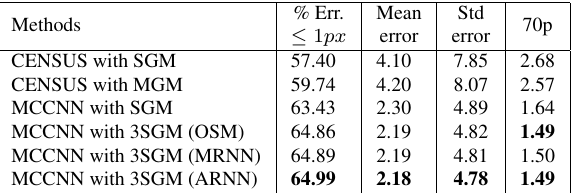
Table 4. Disparity errors (in pixels) on London (UK). All pixels are considered (no rejection criteria).